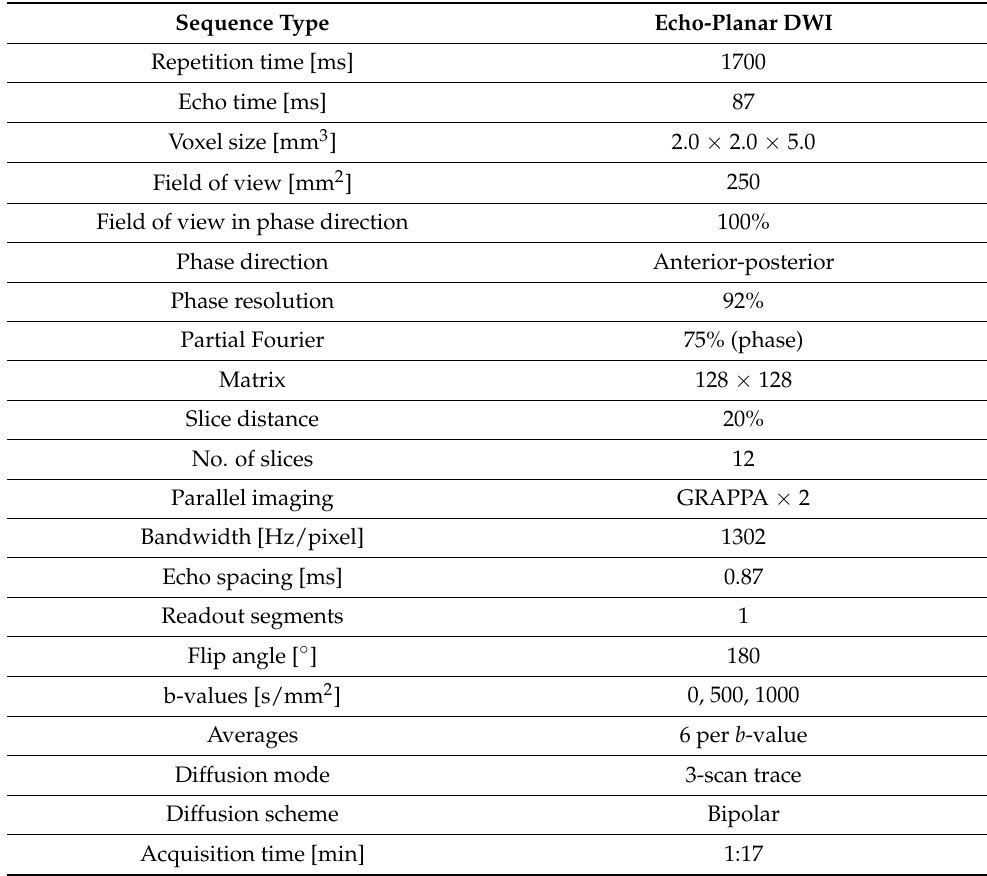
Table 1. DWI sequence